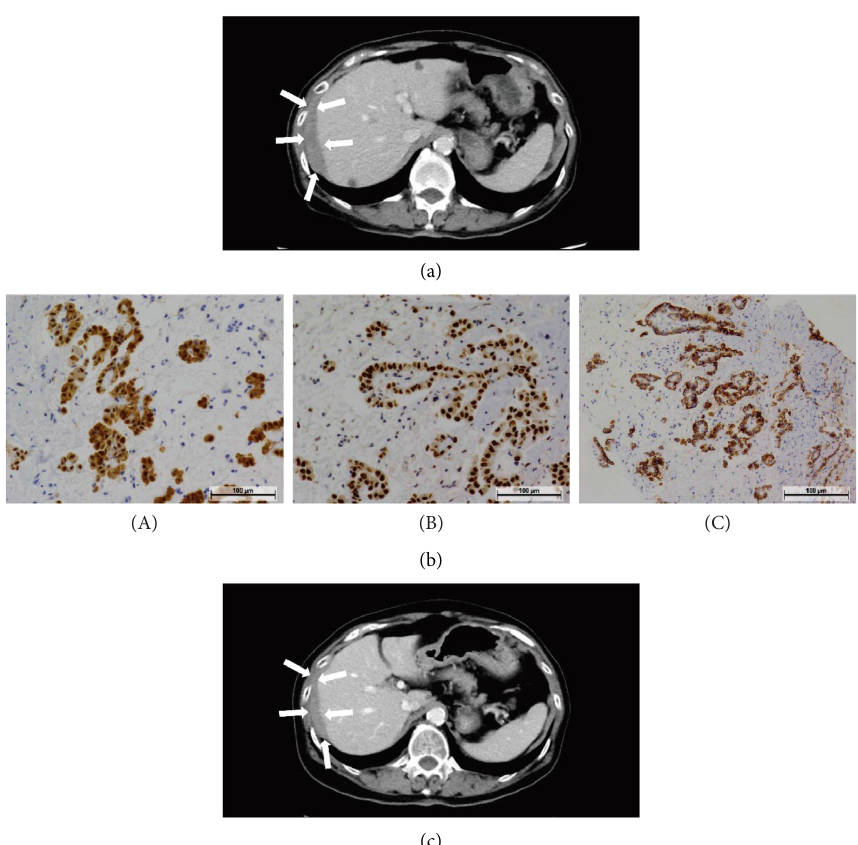
Figure 1: Imaging and immunohistochemistry of the lesion. (a) CE-CT image at the frst visit to our department. Te soft tissue mass is visible below the right diaphragm (arrows). (b) Immunohistochemical analysis of the lesion revealed that the tumor cells were positive for calretinin (A), WT-1 (B), and D2-40 (C). (c) CE-CTimage at 48months after the start of chemotherapy. Te lesions were indicative of stable disease (arrows). CE-CT: contrast-enhanced computed